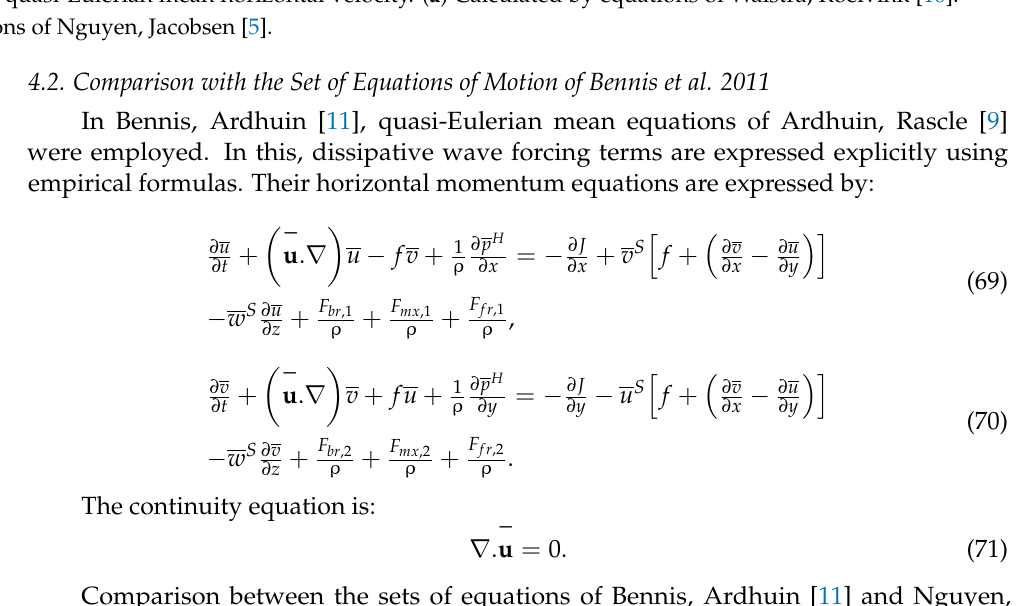
F br ,1 ρ : applied as a surface stress F mx ,1 ρ : was not specified F fr ,1 ρ : applied as a bottom stress